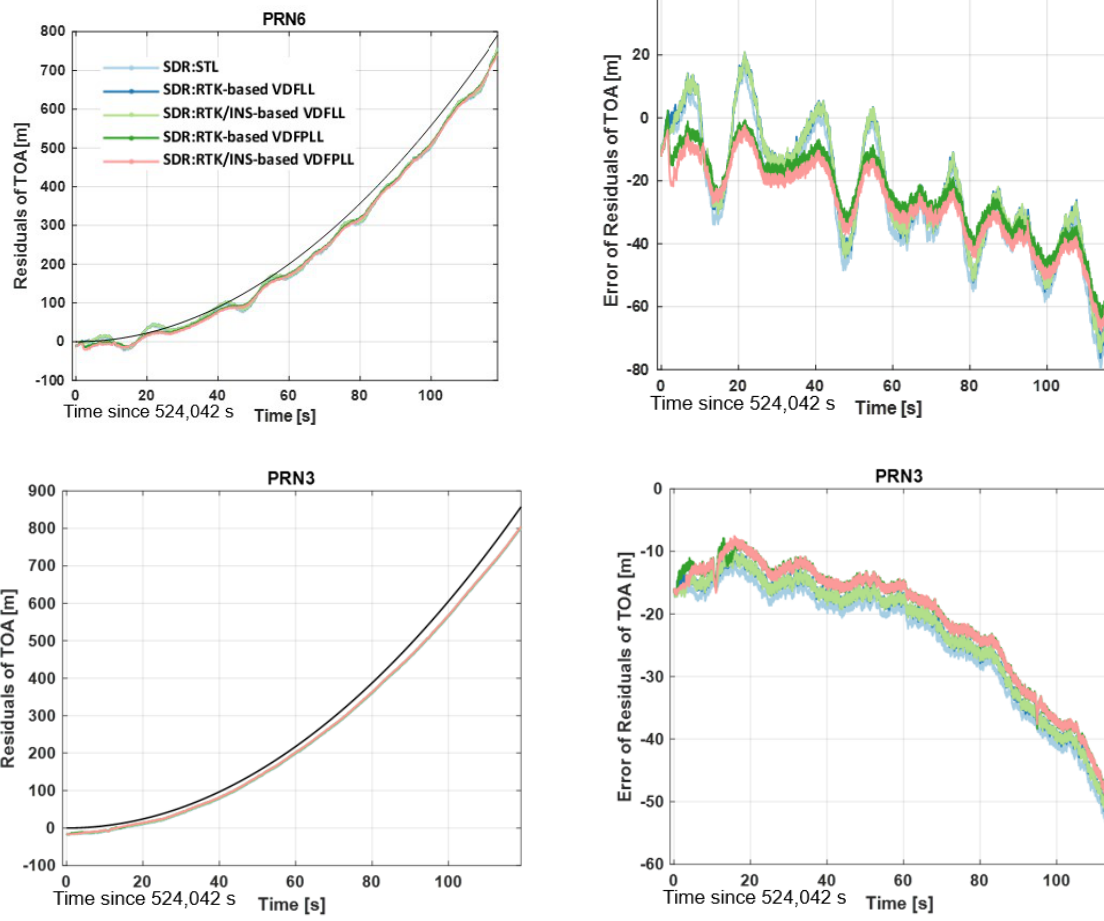
Figure 15. Error curves of the TOA residuals for the GPS satellites PRN6 and PRN3 in the semi-open- sky